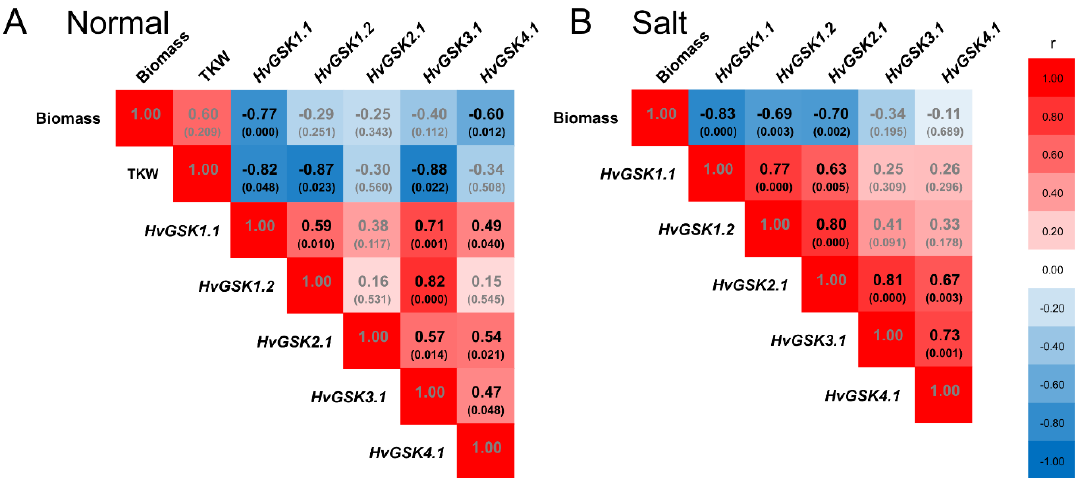
Figure 8. Heat map of the Pearson correlations between expression of HvGSK1.1 , expression of HvGSK paralogs, and values of thousand kernel weight (TKW) measured in the non-transgenic control and the transgenic lines grown in normal conditions ( A ) and in salt stress conditions (Hoagland with NaCl 200 mM) ( B ). Indicated are r values and p values in brackets. Black font indicates significant correlations for p < 0.05. Red blocks indicate a positive correlation and blue blocks indicate a negative correlation.